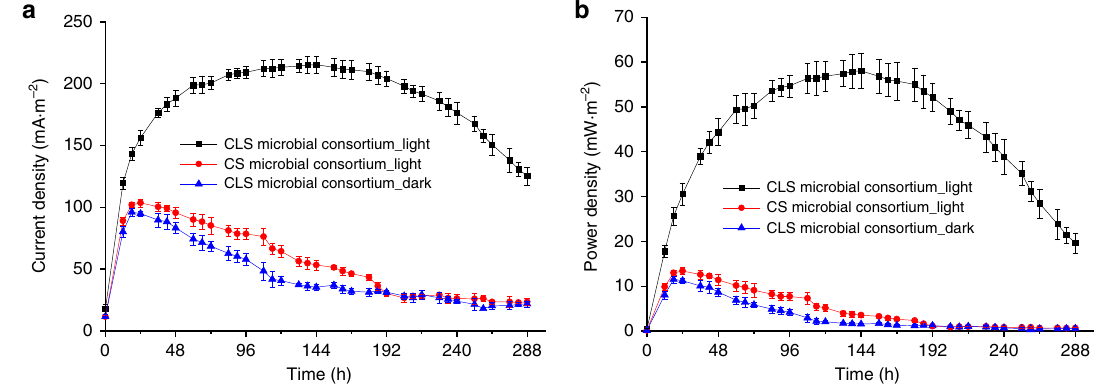
Fig. 5 Achieving longer power output by the spatially separated CLS microbial consortium. Cyanobacteria and S. oneidensis were spatially separated, which allowed D -lactate production under light and current production under dark to be achieved simultaneously. a Current density produced by the microbial consortia constructed under light or dark (for cyanobacterial chambers). b Power density derived from the current density curves. The anodic chambers containing strain S. oneidensis- Δ napA were always shielded from light during the whole experimental process for all setups. Error bars represent the standard deviations from n = 3 independent experiments. Source data are provided as a Source Data fi